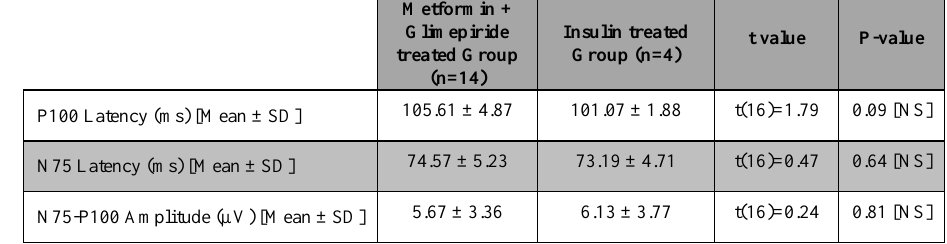
Table 17. Comparison of average VEP wave latencies and the average amplitude of both eyes between metformin and glimepiride treated and insulin (alone or along with oral drugs) treated group of diabetic